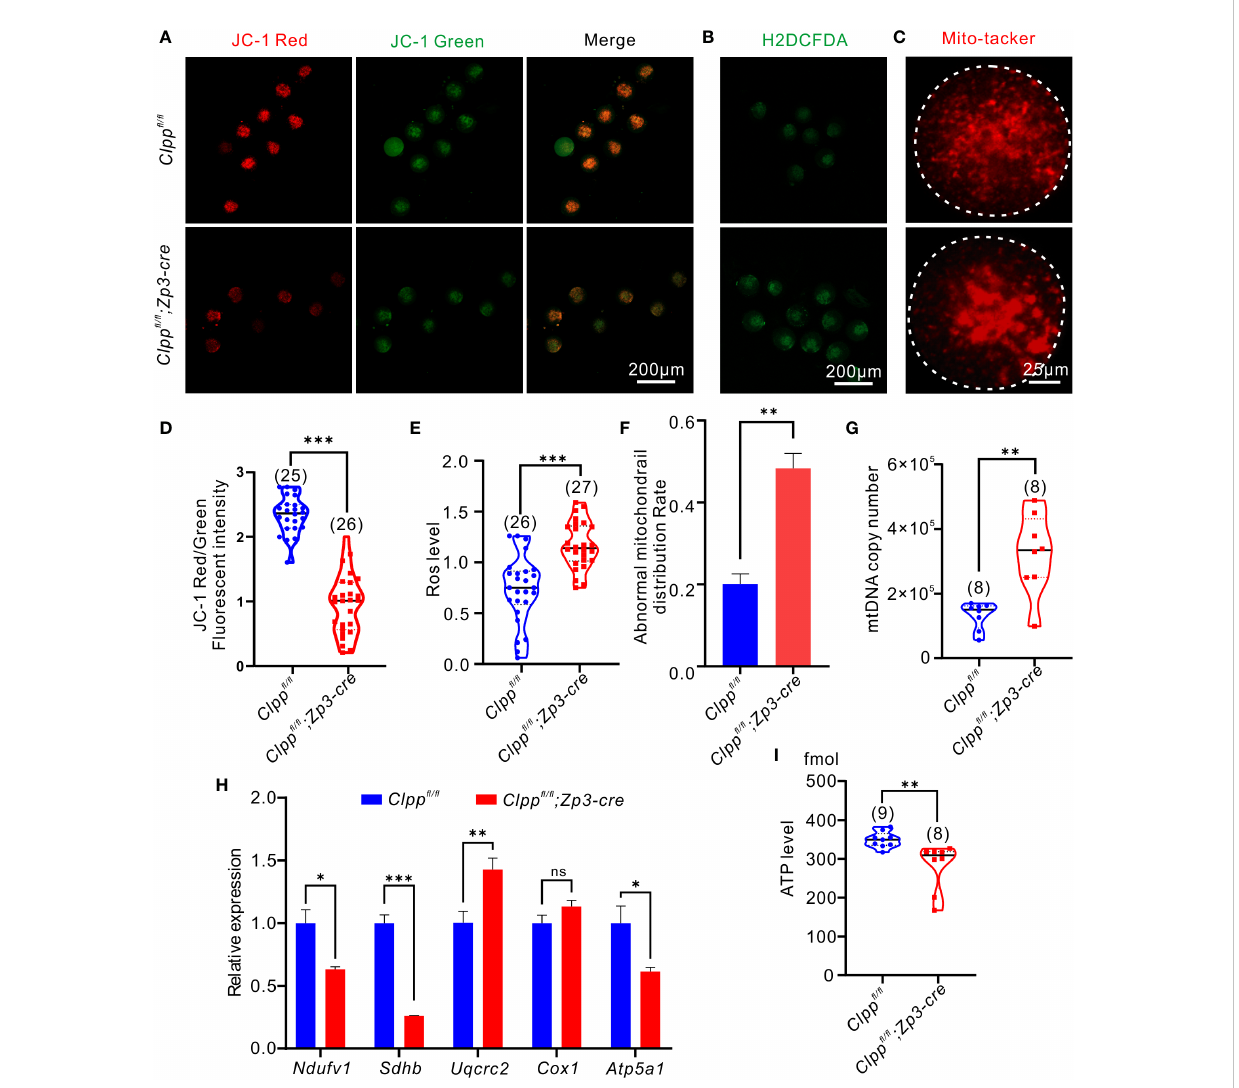
FIGURE 3 Oocyte-speci fi c knockout of Clpp impairs mitochondrial function in MII oocytes. (A) Fluorescent micrographs of MII oocytes (8 weeks old, n=3) stained by mitochondria-speci fi c probe JC-1. Red fl uorescence represents aggregated Mitochondria and green fl uorescence represents monomeric Mitochondria. (B) Using general oxidative stress indicator (Carboxy-H2DCFDA) to ROS level in Clpp fl / fl ; Zp3 -Cre and control MII oocyte (8 weeks old, n=3)following H 2 O 2 treatment. (C) Mito-tracker was used to detect the distribution of mitochondria in oocytes (8 weeks old, n=3). (D) Mitochondrial membrane potential indicated by the red/green fl uorescence intensity ratio. (E) The fl uorescence pixel intensity of ROS levels in Clpp fl / fl ; Zp3 -Cre cKO and control MII oocyte following H 2 O 2 treatment. (F) Ratio of abnormal morphological mitochondrial distribution in oocytes. (G) mtDNA copy number was determined by qPCR in MII oocytes collected from in Clpp fl / fl and Clpp fl / fl ; Zp3 -Cre mice. (H) Expression of respiratory chain genes was assessed using RT – PCR in GV oocytes collected from WT and Clpp fl / fl ; Zp3 -Cre cKO female mice. (I) ATP level in Clpp fl / fl and Clpp fl / fl ; Zp3 -Cre MII oocytes. N.S. means no signi fi cant difference; * p < 0.05; ** p < 0.01; *** p < 0.001. All the oocyte and ovary samples were from 8-week-old female mice. The results represent mean ± SEM. Signi fi cance was determined by Student t test. Atp5a1 , ATP synthase, H+ transporting, mitochondrial F1 complex; alpha subunit 1; Cox1 , cytochrome c oxidase subunit I; Ndufv1 , NADH dehydrogenase (ubiquinone) fl avoprotein 1; Sdhb , succinate dehydrogenase complex iron sulfur subunit B; Uqcrc2 , ubiquinol cytochrome c reductase core protein